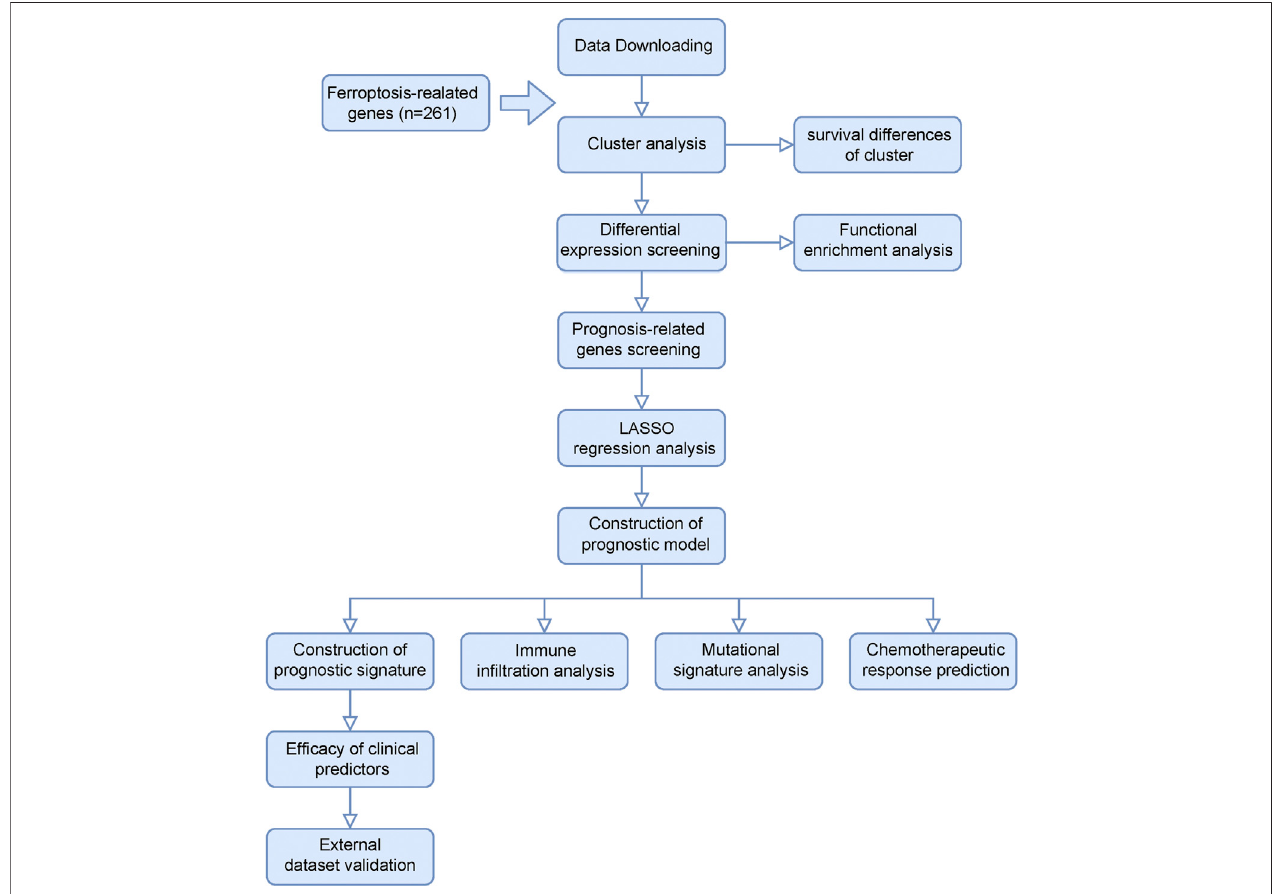
FIGURE 1 | Flow chart of our study